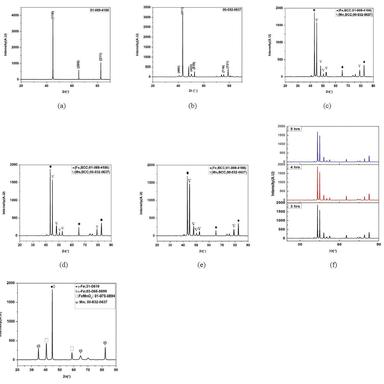
XRD peaks of (a) Pure Fe, (b) Pure Mn, (c) 3 h milled powders, (d) 4 h milled powders, (e) 5 h milled powders, (f) comparison XRD graph, (g) After sintering of 3 h pellet.